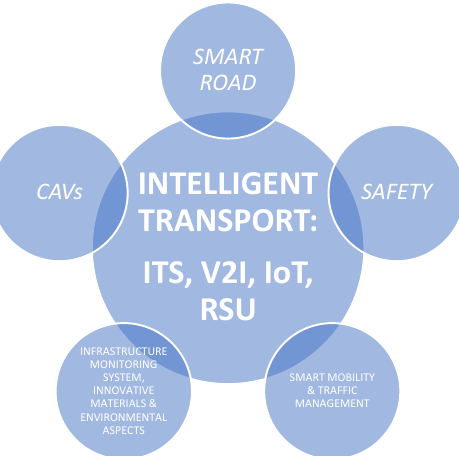
Figure 9. Proposal future works scheme.